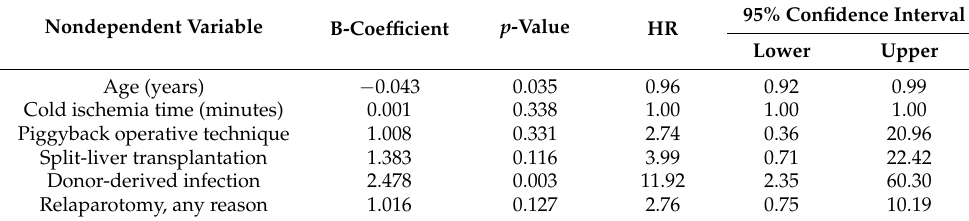
Table 3. Identification of risk factors for b-IFI: multivariate analysis ( n =